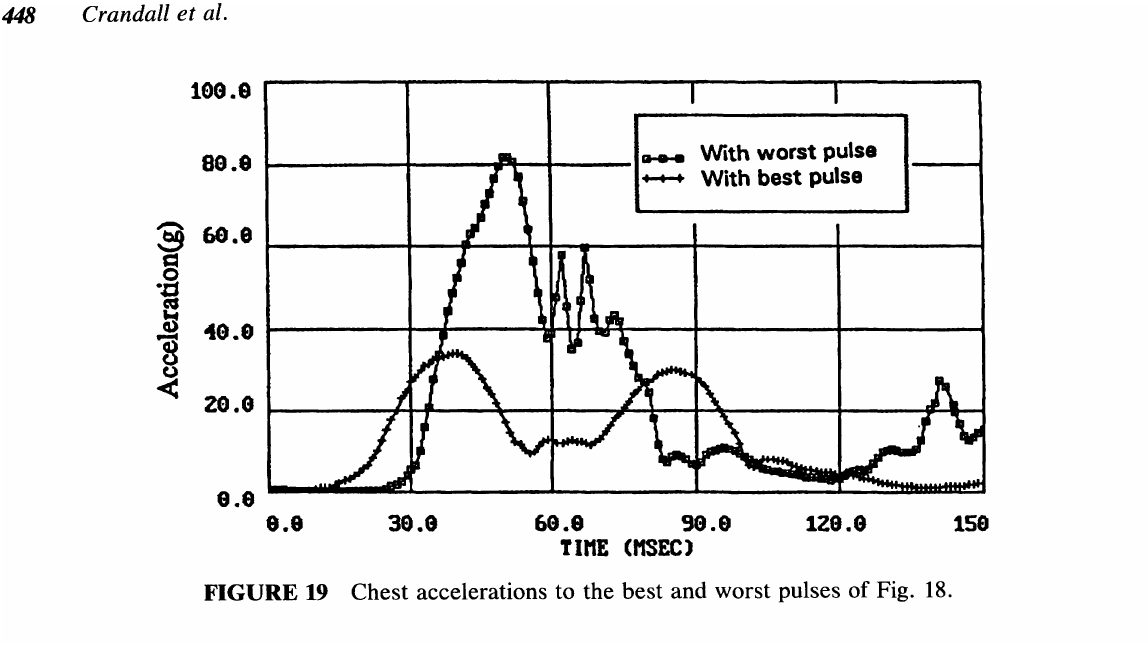
FIGURE 19 Chest accelerations to the best and worst pulses of Fig. 18.